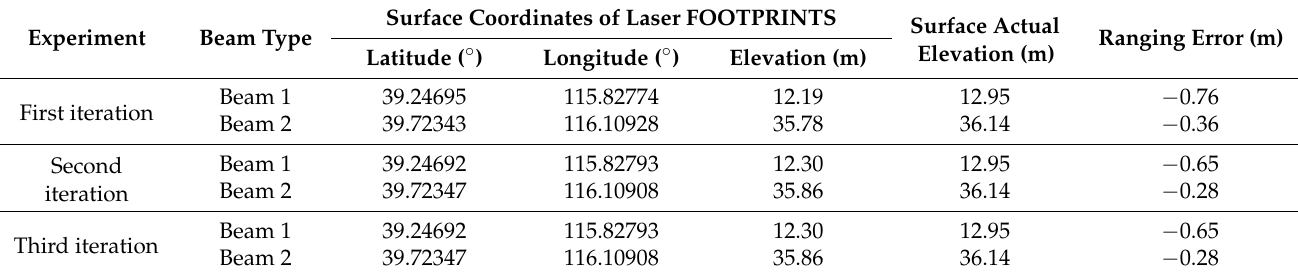
Table 2. The ranging error of the GF-7 laser based on three iterations of AW3D30